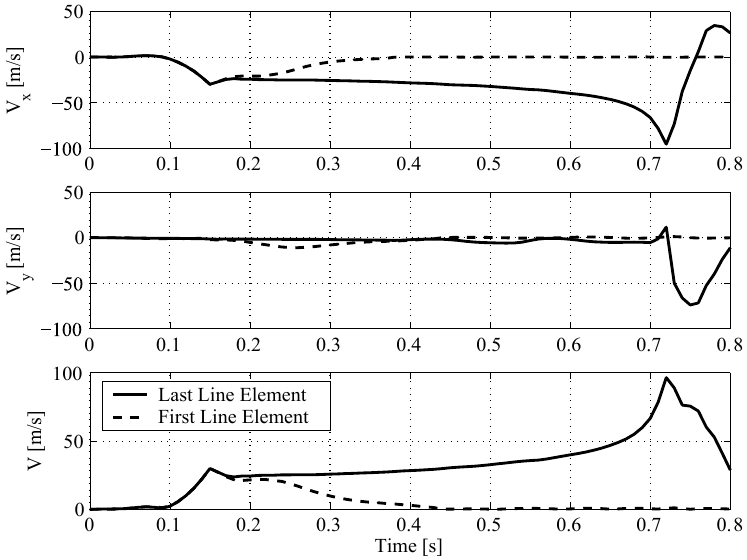
Fig. 14. Fly line fi rst/last element velocity time history during a cast [Flexible Rod Case]. fi shing rod under a forward casting stroke. The deformed shape of the fl y rod was plotted in Fig. 9 during the